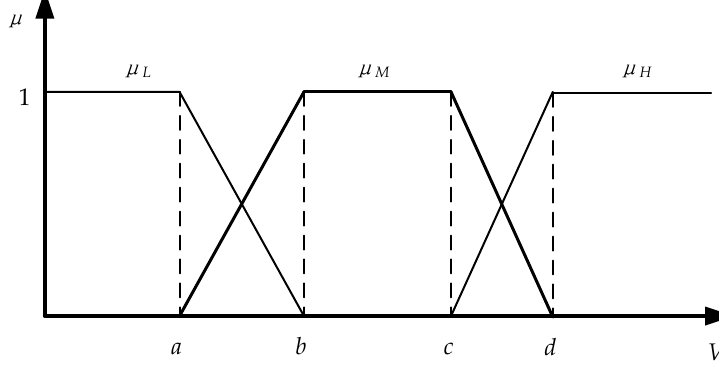
Figure 3. The diagram of its membership function.